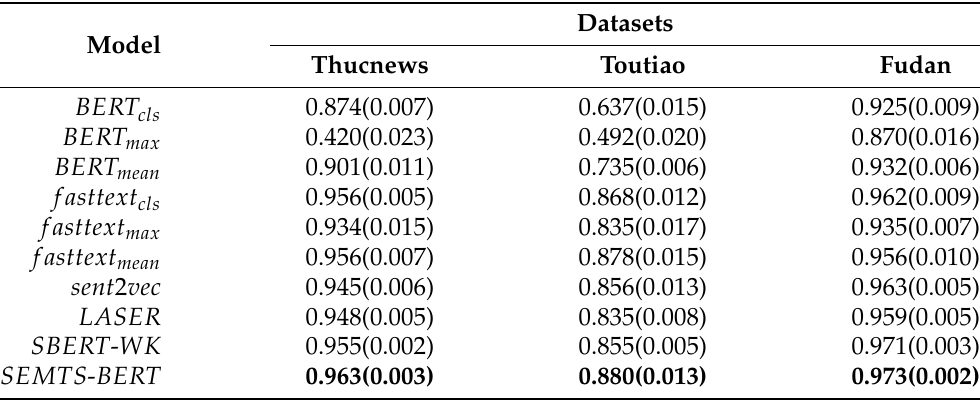
Table 3. Experimental results of text